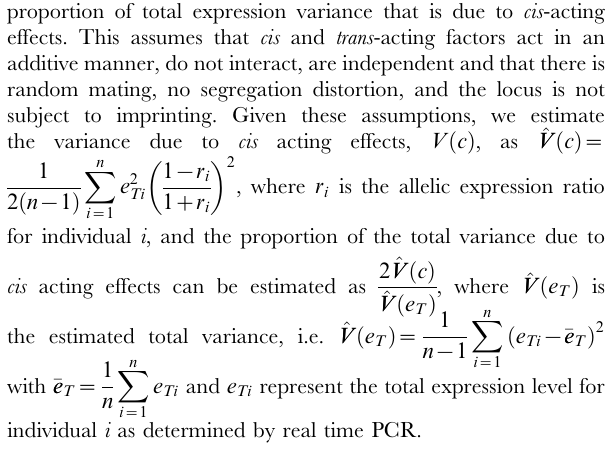
Figure S7 Linkage disequilibrium in the SA and Caucasian cohorts. Figures show linkage disequilibrium between the 56 SNPs in each population: (A) D 9 in Caucasian cohort; (B) D 9 in SA cohort; (C) r 2 in Caucasian cohort; (D) r 2 in SA cohort. Colouring in (A) and (B) represents D 9 values: D 9 = 1, LOD , 2 (blue); D 9 = 1, LOD . 2 (red); D 9, 1, LOD . 2 (shades of pink); D 9, 1, LOD , 2 (white). Shading in (C) and (D) represents r 2 values: r 2 = 1 (black); 0 , r 2 , 1 (shades of grey); r 2 = 0 (white).